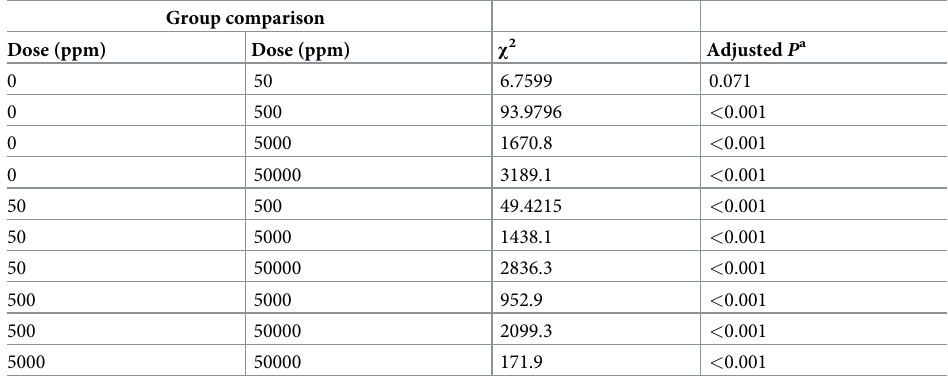
a P -values from pair-wise comparisons were adjusted for multiplicity using the SIMULATE option of the LIFETEST procedure of SAS